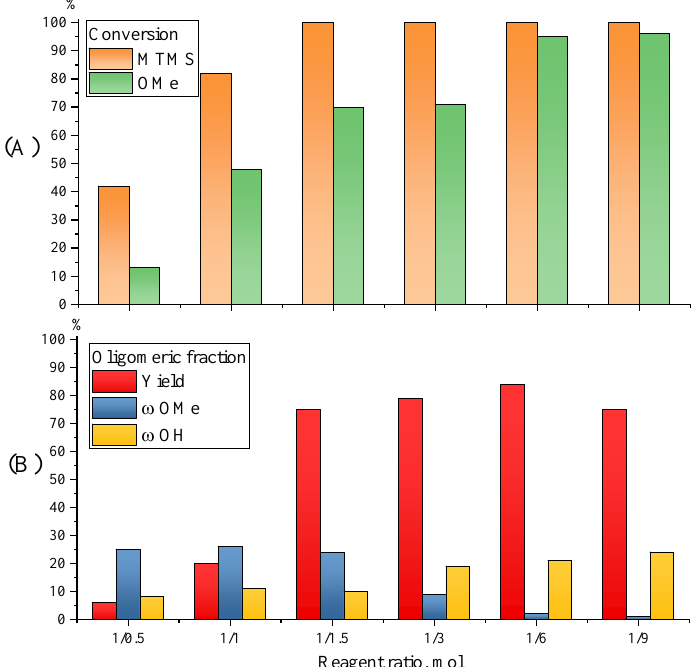
Figure 7. Diagrams of monomer and MeO-group conversions ( A ) and of the yield, MeO- and OH- group contents in the oligomeric fraction ( B ) obtained by MTMS MWHP at different reagent ratios and at 30 ◦ C, 20 W for 90 min (Samples 1–6, Table